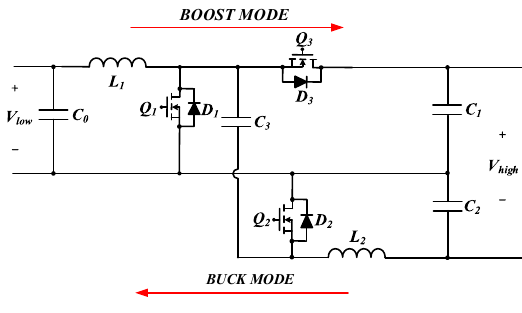
Figure 2. Proposed converter II (boost + Ć uk).